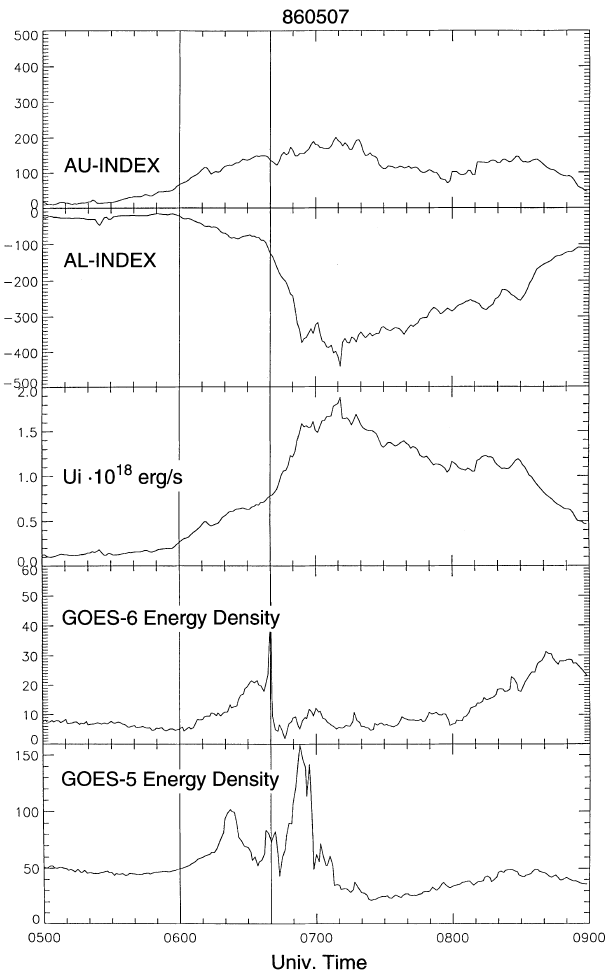
Fig. 10. From top to bottom panels : the AU and AL index, the energy consumption rate in the auroral ionosphere and magnetic energy density from GOES-6 and GOES-5 satellites for the May 7, 1986 event. The two vertical lines indicate the substorm growth phase according to the AL and AU index